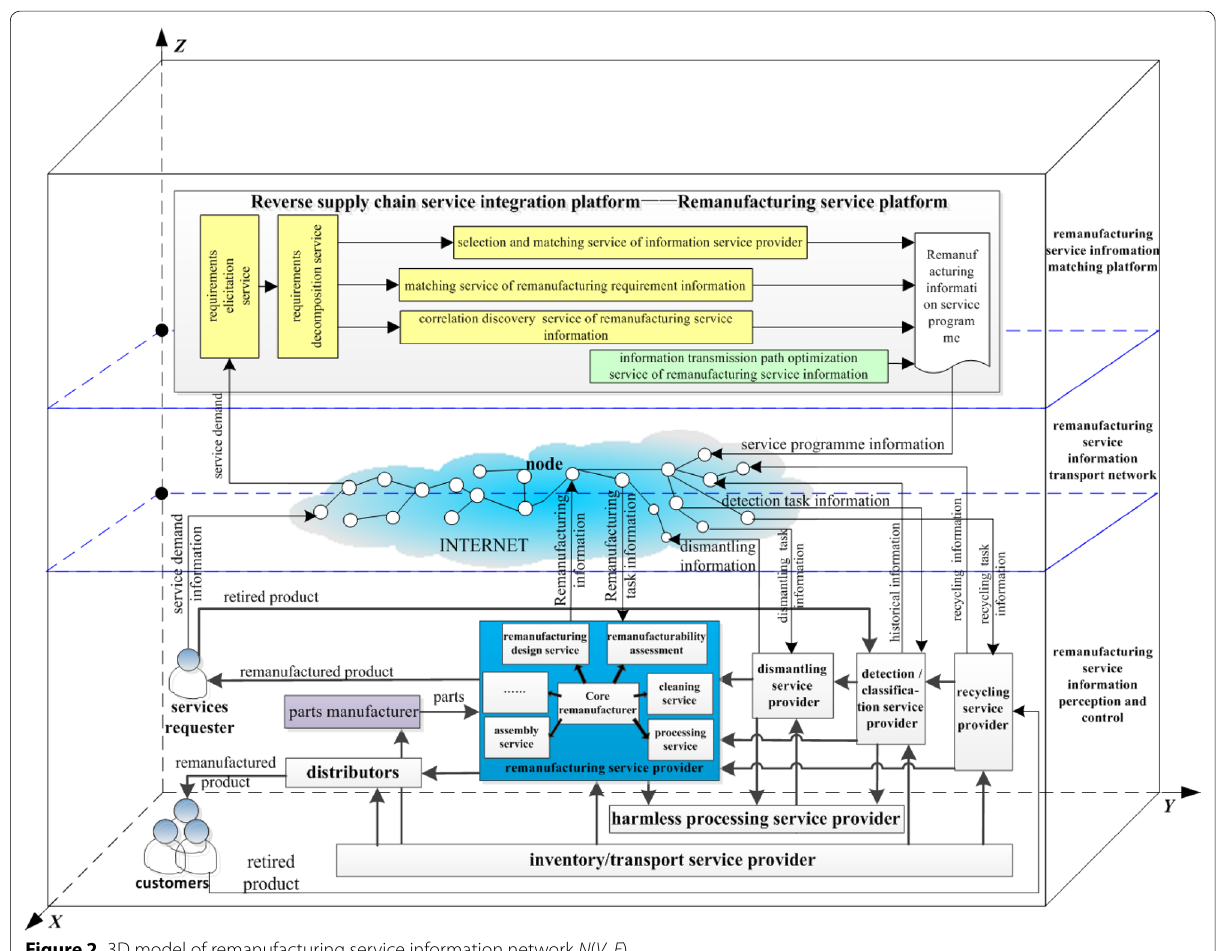
Figure 2 3D model of remanufacturing service information network N ( V , E )